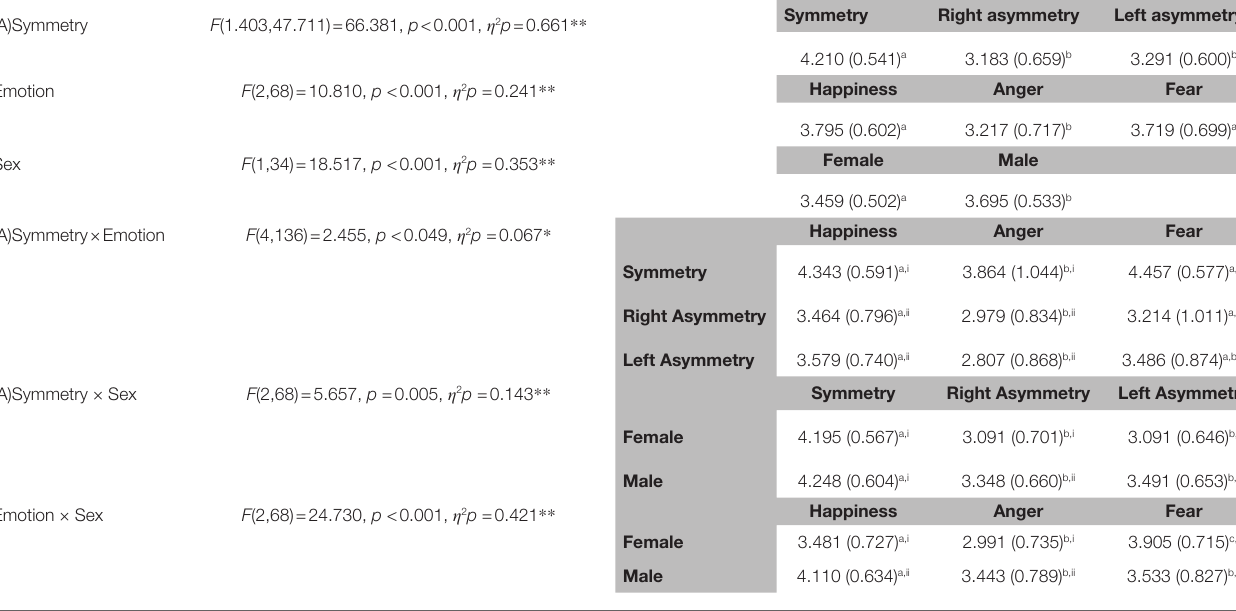
a, b, c Indicate the (non) significant differences for horizontal lines. i, ii, iii Indicate the (non) significant differences for vertical columns. * Indicates p < 0.05; ** Indicate p <